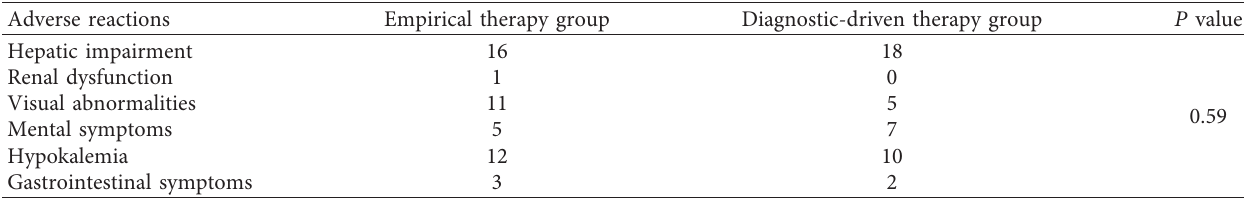
Table 5: Adverse reactions related to antifungal treatment in the empirical therapy and diagnostic-driven therapy groups.